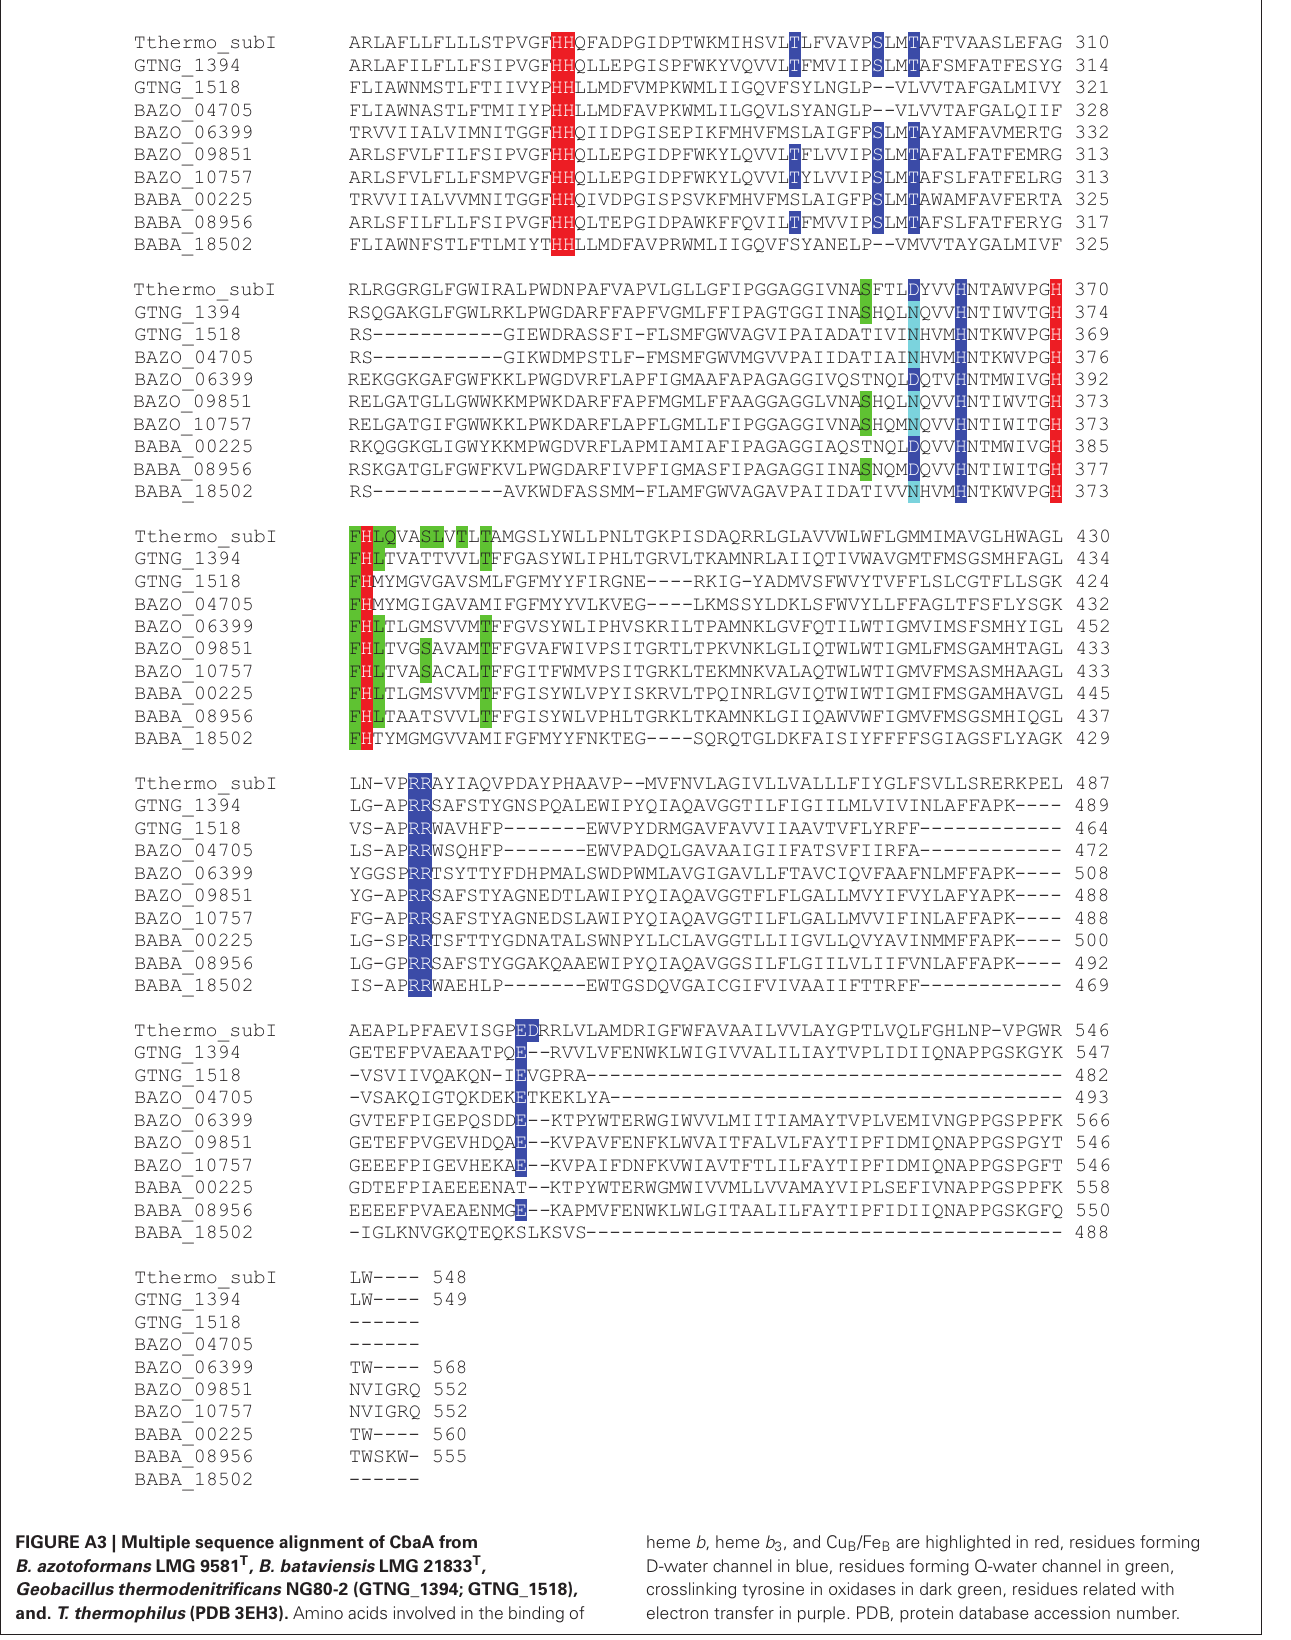
heme b , heme b 3 , and Cu B /Fe B are highlighted in red, residues forming D-water channel in blue, residues forming Q-water channel in green, crosslinking tyrosine in oxidases in dark green, residues related with electron transfer in purple. PDB, protein database accession number.